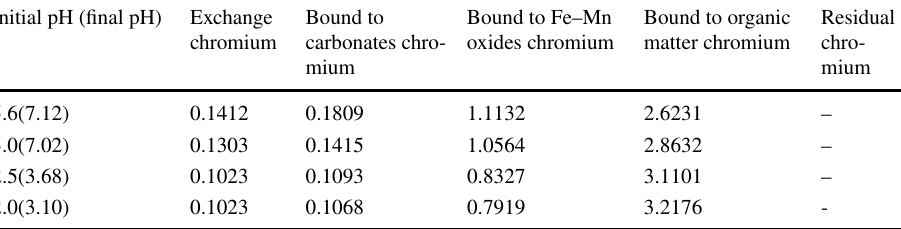
Table 2 Content of different forms of